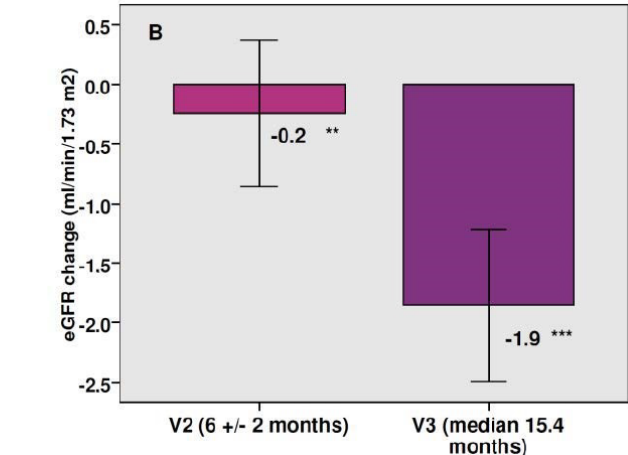
Figure 3. Changes in eGFR after therapy with canagliflozin in patients with baseline eGFR equal to or above 60 mL/min/1.73 m 2 (91.4%, mean baseline eGFR 88 mL/min/1.73 m 2 , panel ( A )) and in pa- tients with baseline eGFR below 60 mL/min/1.73 m 2 (8.6%, mean baseline eGFR 53.5 mL/min/1.73 m 2 , panel ( B )). Bars: mean change ± SEM. * p < 0.0001 vs. baseline, ** p non-significant vs. baseline, *** p = 0.02 vs. baseline. Fourteen (2.4%) patients (five treated with the 100 mg dose and nine with the 300 mg dose) showed an eGFR decrease greater than 30% at the end of the follow-up period. Base- line characteristics of these patients were similar to those of the entire cohort, except they had a lower baseline eGFR (65.2 vs. 86.5 mL/min/1.73 m 2 , p < 0.0001). SGLT-i therapy was identified as the most likely cause of rapid decline of eGFR in this group. Doubling of serum creatinine was found in three patients. Only one patient on canagliflozin 100 mg and one patient on canagliflozin 300 mg stopped the drug due to worsening of renal func- tion. No meaningful changes in any anti-hypertensive medications were reported during the study. The best predictive model of eGFR decline after canagliflozin therapy included age, hypertension, combined hyperlipidemia, heart failure, eGFR and severely increased albu- minuria (Table 2). All these variables except hypertension were independently associated